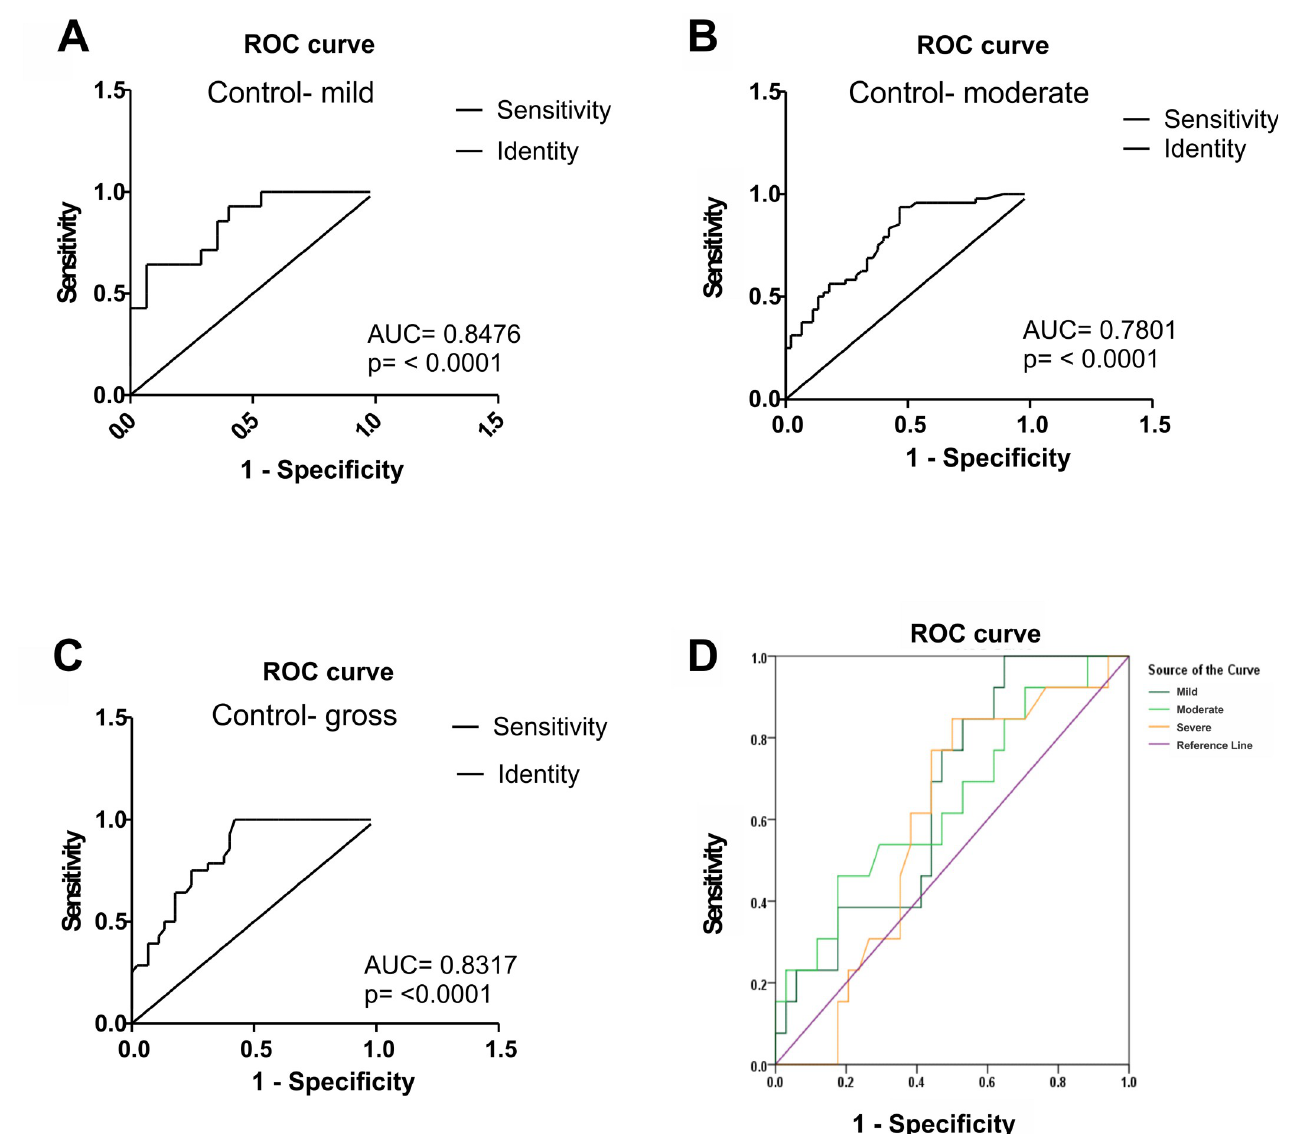
Fig 5. Receiver Operating Characteristic (ROC) curve of serum miR-122 in the HCV patients. ROC curves have been drawn and AUC curves were used to assess and examine the diagnostic ability of miR-122. A-C: The miR-122 healthy control was compared to HCV cirrhotic patients (mild, moderate, and severe group). D: shows the combined ROC curve of the HCV patients’